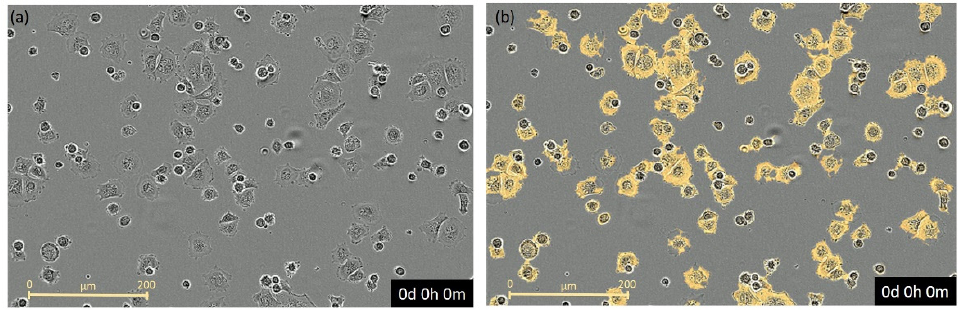
Figure 1. Cells of Atlantic sturgeon ( a ) in phase contrast and ( b ) with overlain masked (yellow) of attached cells for analysis of confluence generated by Incucyte ® real ‐ time video imaging system (Sartorius AG). attached cells for analysis of confluence generated by Incucyte (Sartorius